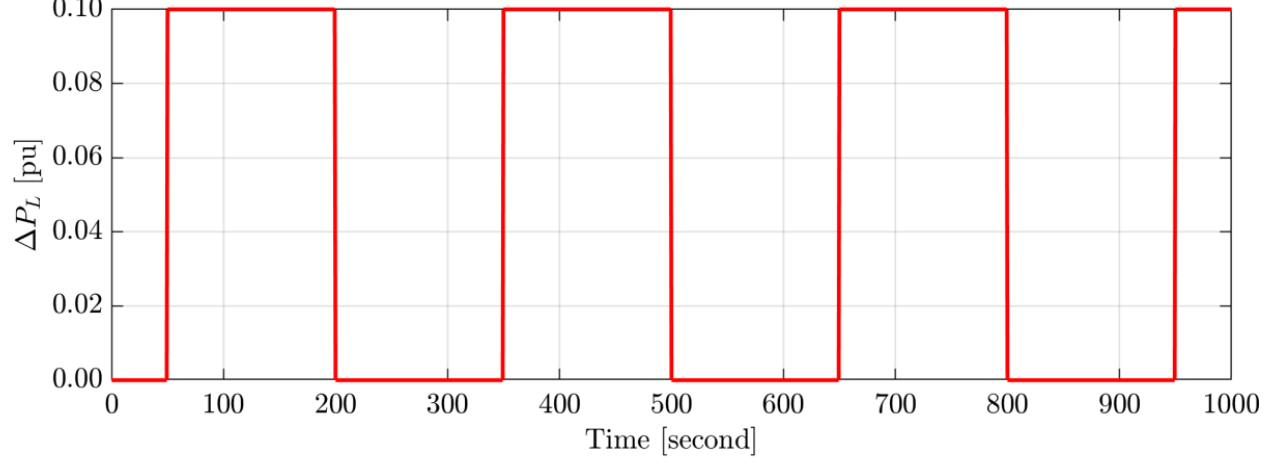
Figure 17. Series of step load change for the case 4.